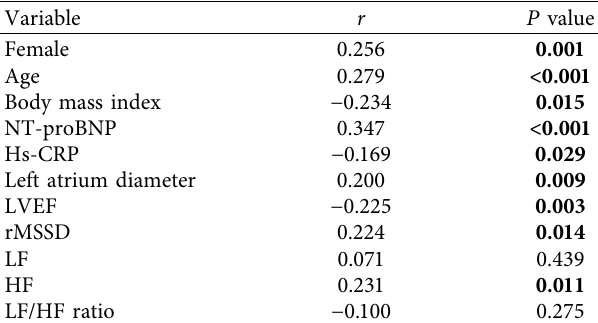
Figure 2: Correlation analyses between serum adiponectin and clinical parameters in the included participants: (a) correlation of adi- ponectin with NT-proBNP; (b) correlation of adiponectin with hs-CRP; (c) correlation of adiponectin with left atrium diameter (LAD); (d) correlation of adiponectin with LVEF; (e) correlation of adiponectin with root mean square successive difference (RMSSD); (f) correlation of adiponectin with high-frequency power (HF). Table 2: Correlation between plasma adiponectin concentration and other